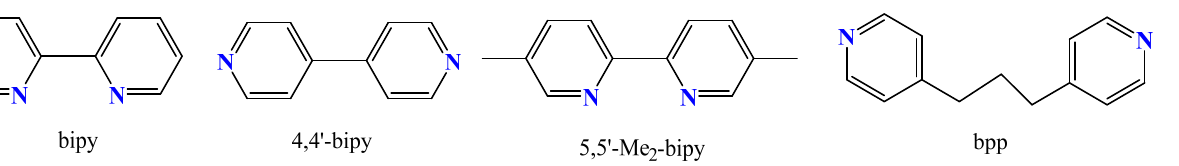
Figure 7. The syntax formula of bipyridine derivatives: bipy = 2,2′–bipyridine; 4,4′–bipy = 4,4′–bipyridine;